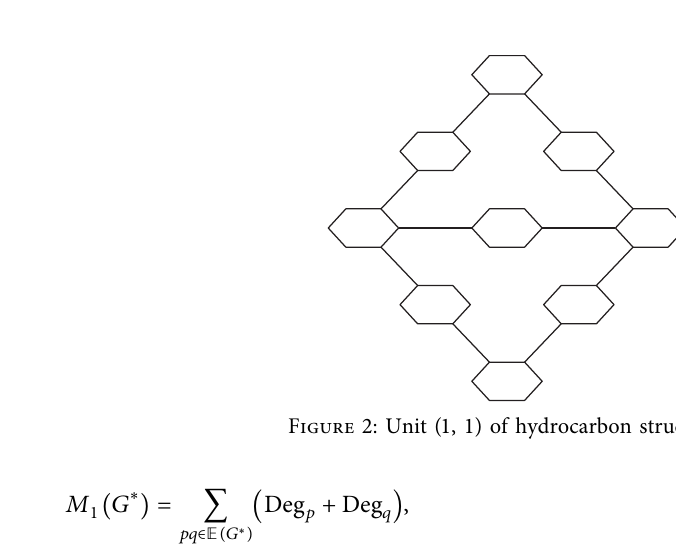
Figure 1: Unit (2, 3) of hydrocarbon structure.